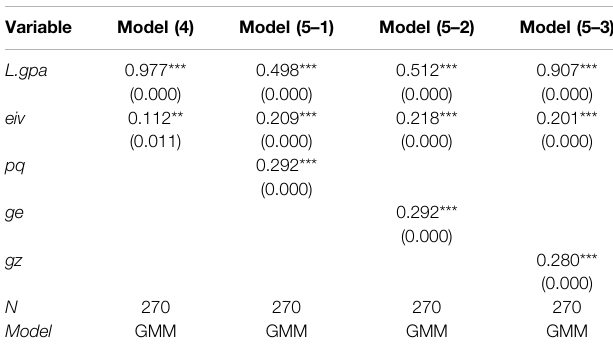
TABLE 6 | Baseline results of